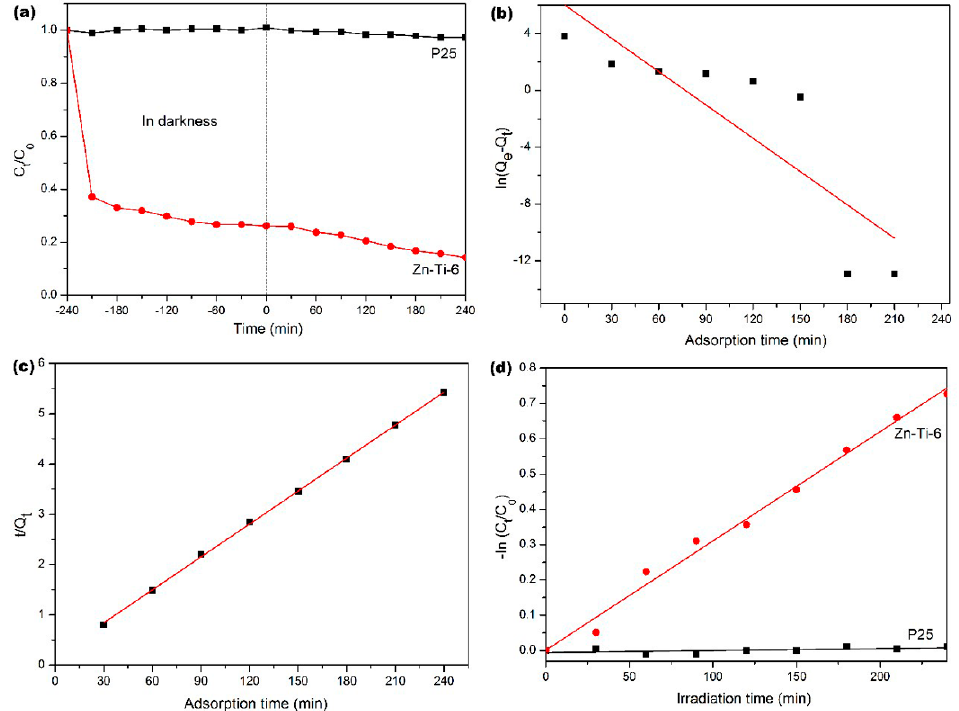
Figure 5. ( a ) Adsorption and photocatalytic degradation of MB solution (60 mg/L, 50 mL) by P25 and Zn-Ti-6. Adsorption kinetic models in the linear transformation for Zn-Ti-6: ( b ) pseudo-first- order and ( c ) pseudo-second-order. ( d ) First-order kinetic fitting for P25 and Zn-Ti-6 photocatalytic degradation of MB solution.